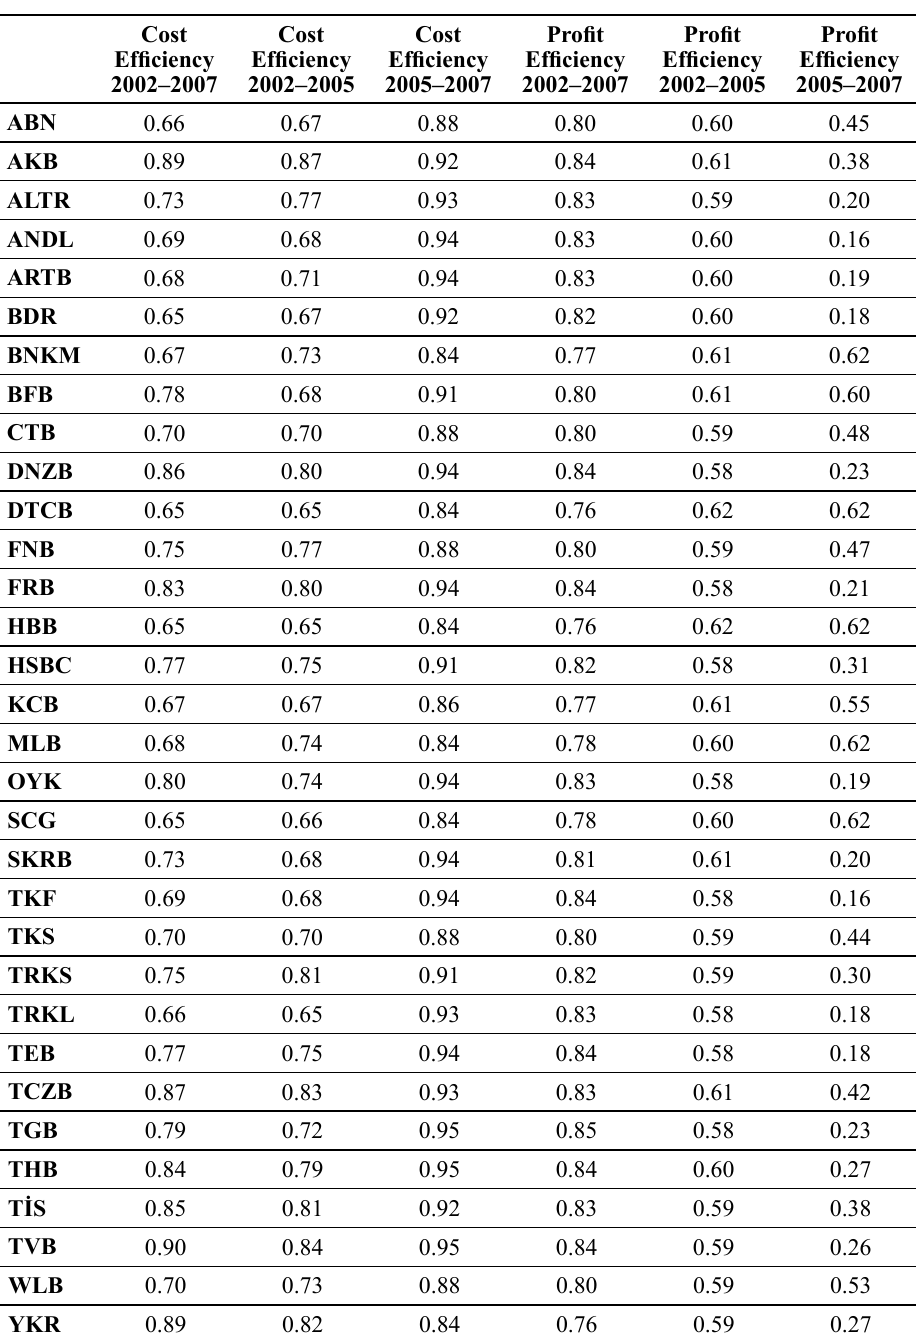
Table 5. Cost-Profit Efficiency